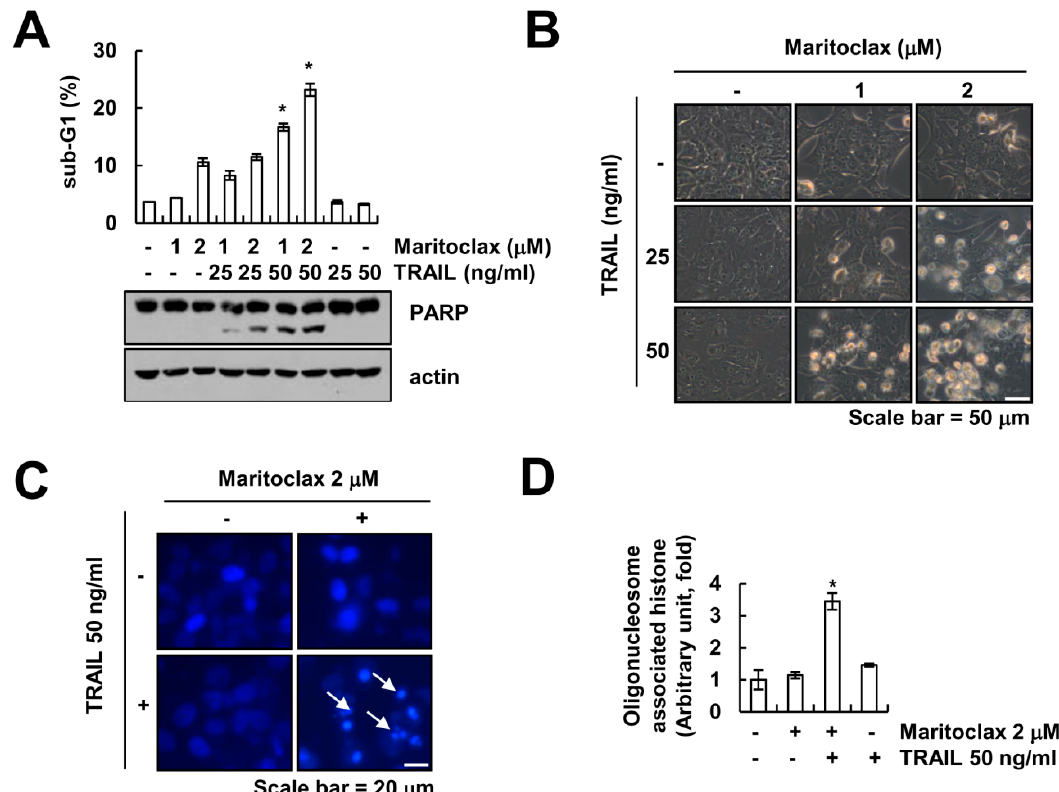
Figure 1. Maritoclax enhances TRAIL-induced apoptosis in Caki cells. ( A , B ) Caki cells were treated with TRAIL (25 and 50 ng/mL) in the presence or absence of the indicated concentrations with maritoclax for 24 h. Apoptosis was analyzed as a sub-G1 population by flow cytometer. The protein levels of PARP and actin were determined by Western blotting ( A ). The cell morphology was examined using interference light microscopy ( B ). ( C , D ) Caki cells were treated with 50 ng/mL TRAIL in the presence or absence of 2 μ M maritoclax for 24 h. The condensation and fragmentation of the nuclei were detected by 4 ′ ,6 ′ -diamidino-2-phenylindole staining ( C ). The DNA fragmentation detection kit determined the fragmented DNA ( D ). − , no treatment; +, treatment. The values in graph ( A , D ) represent the mean ± SD from three independent samples. * p < 0.01 compared to the control by ANOVA and Student-Newman-Keuls methods.